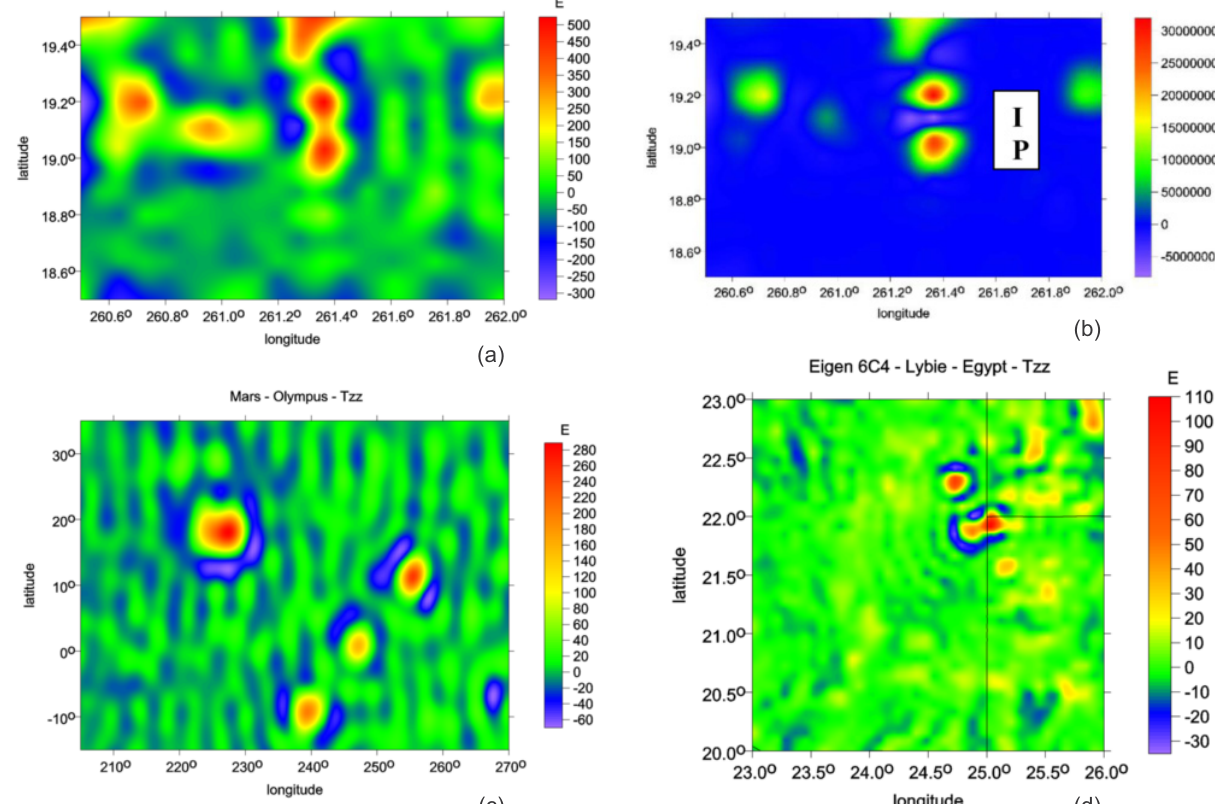
and (b) I . (c) The values of T for zz zz 2 for zz